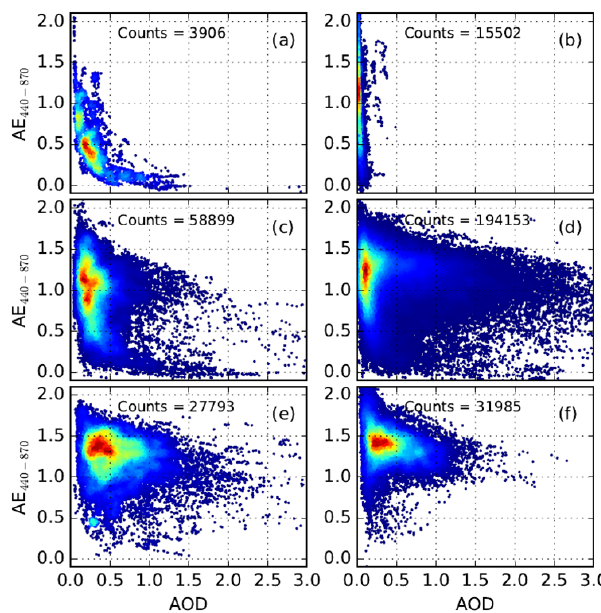
Figure 6. The AERONET-observed Ångström exponent versus AOD for (a) the Hexi Corridor of Gansu (desert region); (b) the Ti- betan Plateau (TP); (c) the Loess Plateau (LP); (d) the North China Plain (NCP); (e) the Yangtze River Delta (YRD); and (f) the Pearl River Delta (PRD). Similarly to Fig. 4, the color represents the num- ber density of the Ångström exponent versus AOD data points.